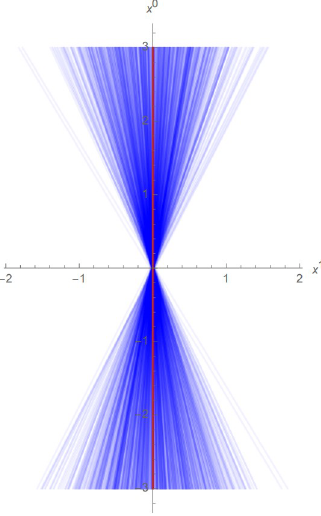
Figure 2 . Several sections y = constant (left) and η = constant (right) of the distribution G ( y, η ) , eq. (5.2), for σ = σ = 0 . 2 . p q